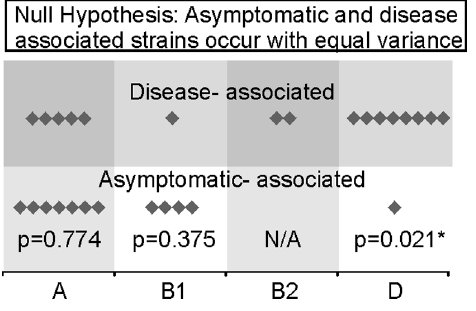
Figure 1. Distribution of asymptomatic and disease-associated EAEC strains across the four ECOR phylogroups. Strains from phylogroup A (12 strains) and B1 (5 strains) are equally distributed between the two groups. EAEC strains for phylogroup D (9 strains) are not equally distributed being highly associated with cases. There were not enough strains from phylogroup B2 (2 strains) for statistical analysis.